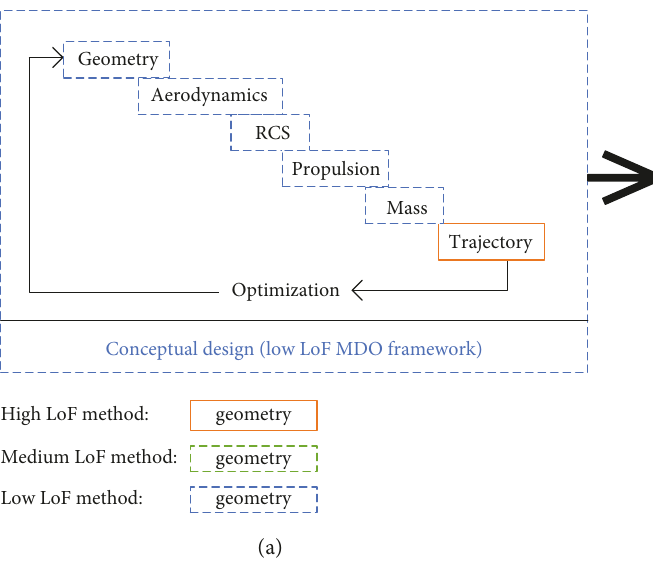
Figure 2: Multi fi delity MDO